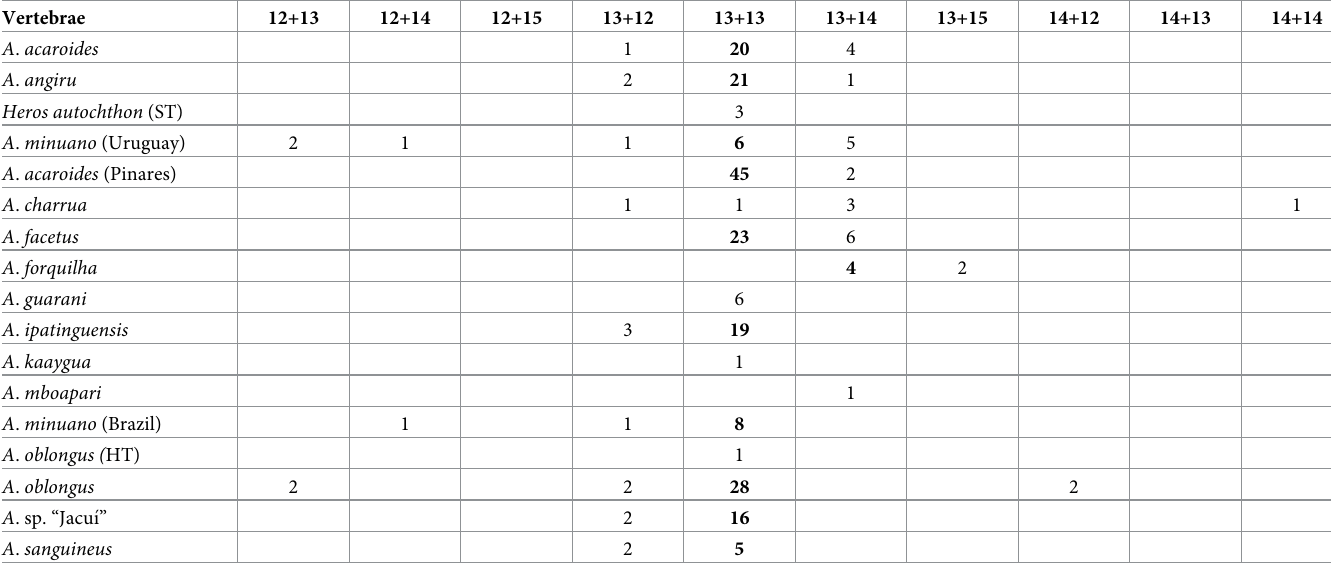
Table 3. Number of vertebrae in species of Australoheros .